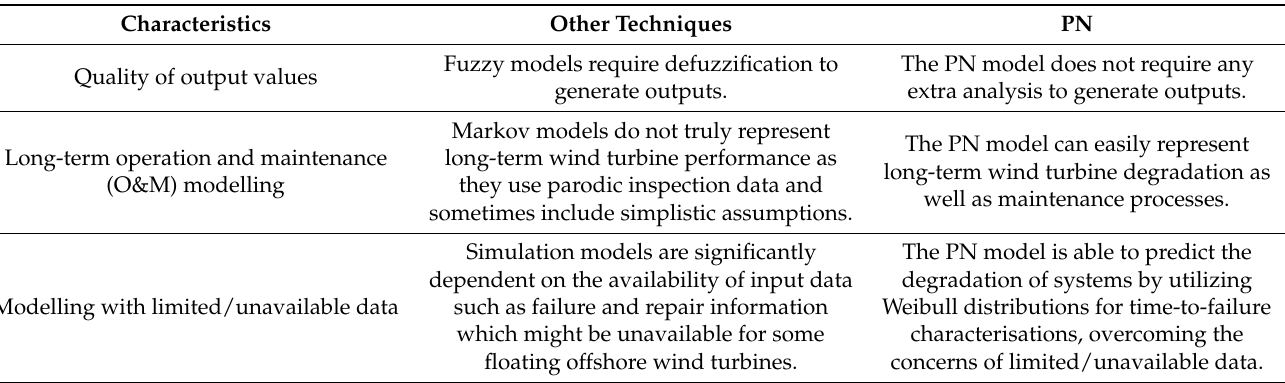
Table 1. Comparison of Petri network (PN) model with other analytics